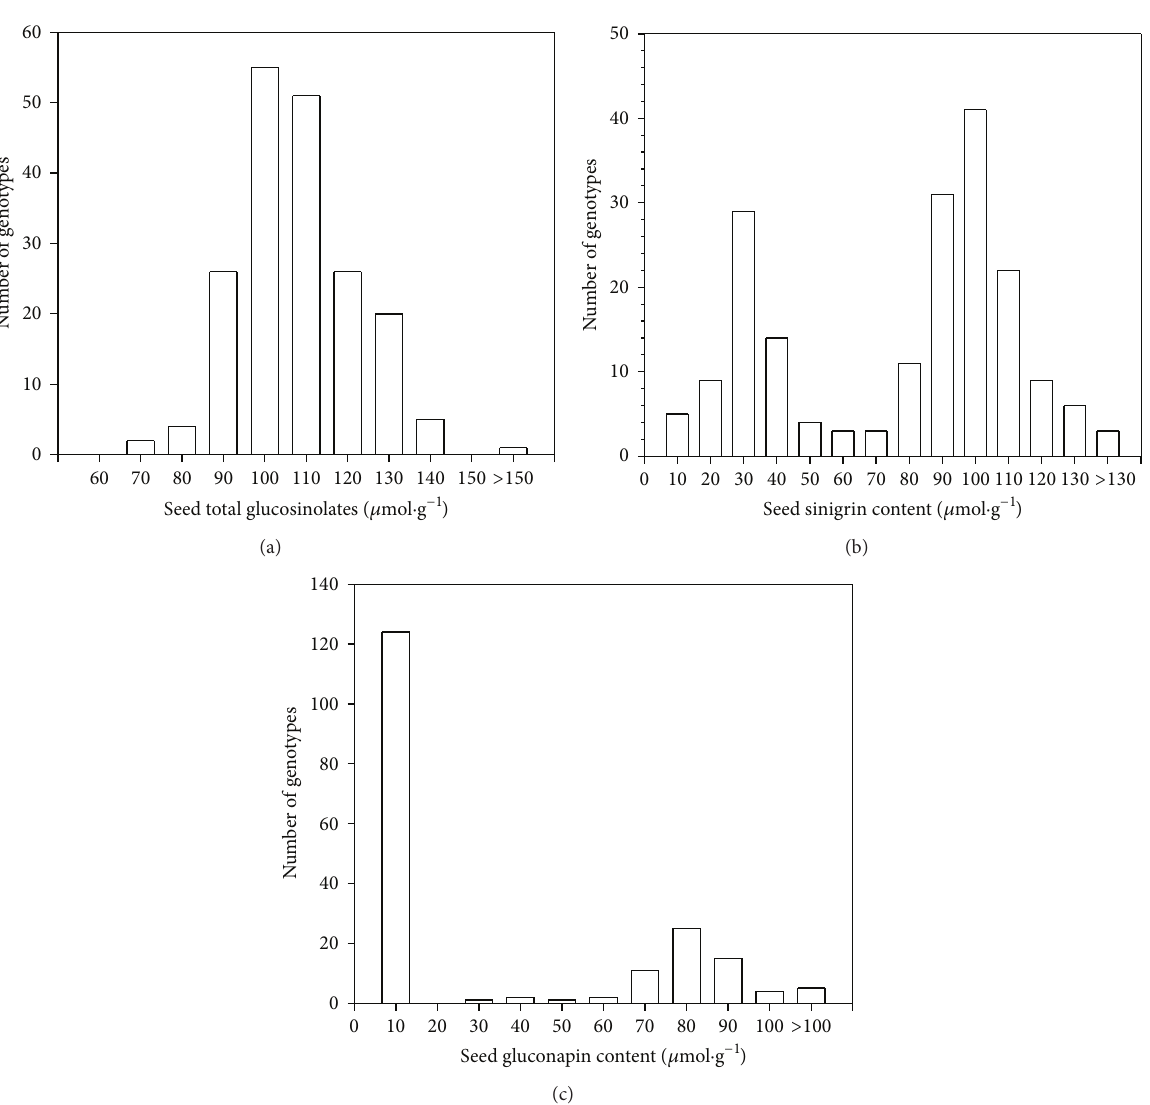
Figure 1: Distribution of seed total glucosinolates, sinigrin, and gluconapin values assessed on a collection of 190